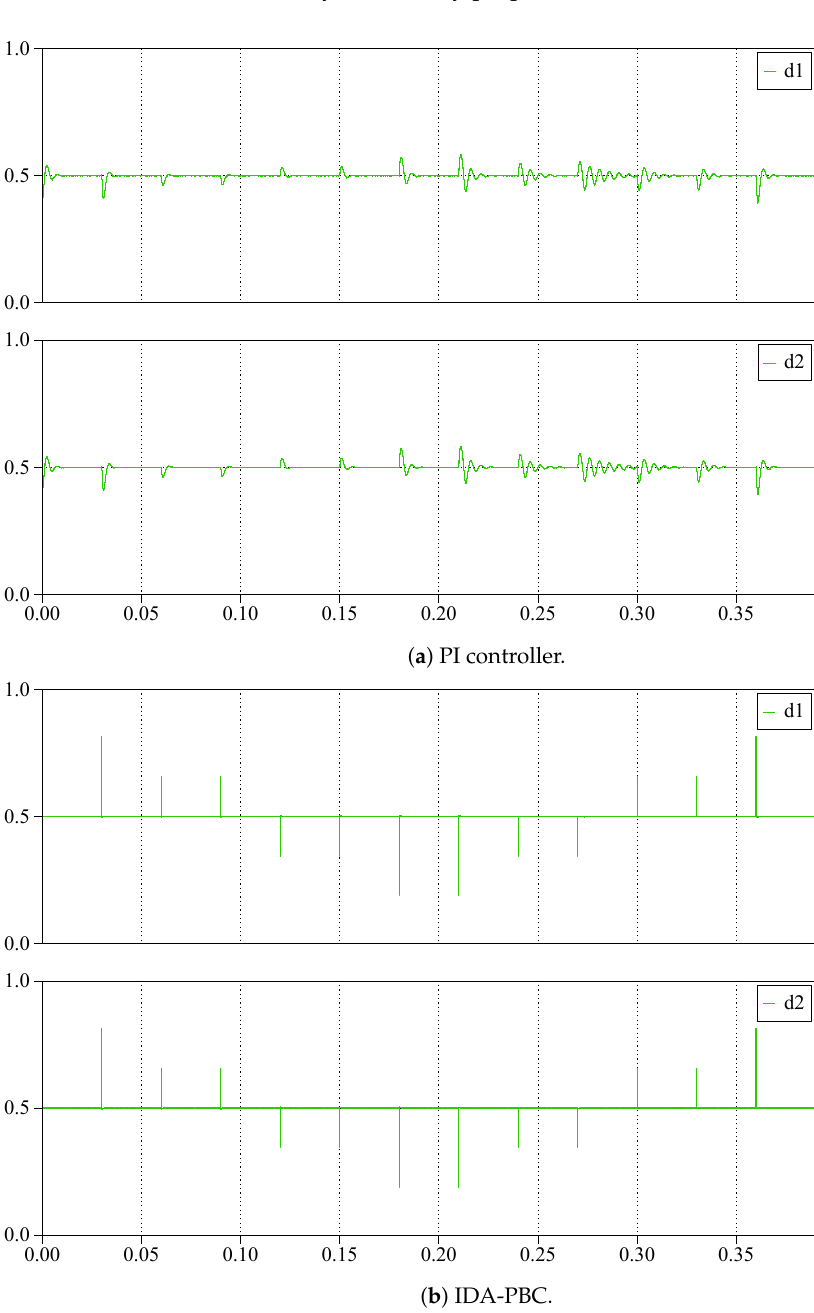
Figure 6. The dynamic response of control inputs with the interleaved boost converter under different DC current